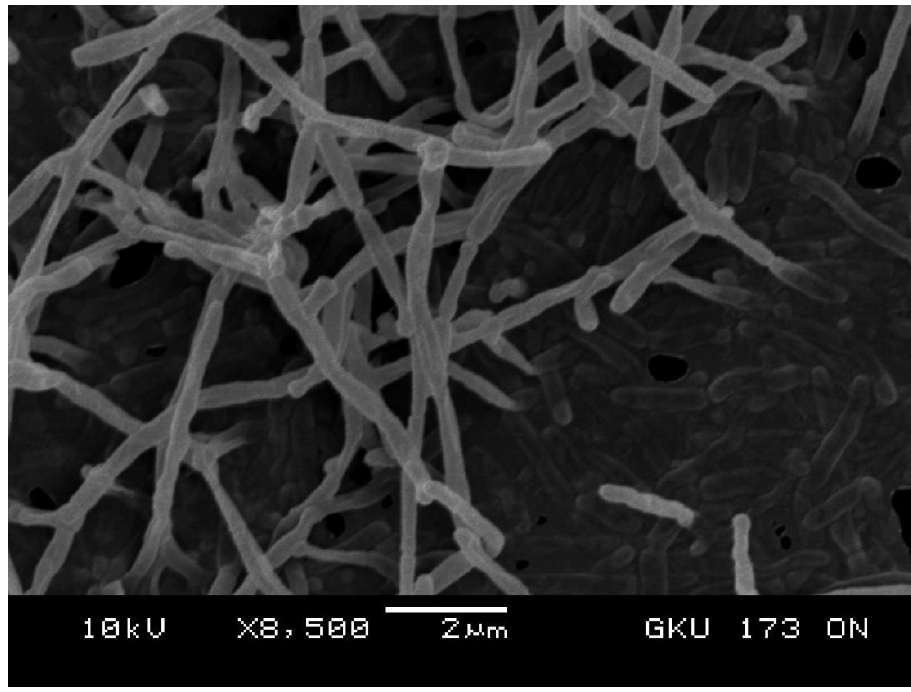
Figure 1. Scanning electron micrograph of fragmentation of aerial hyphae of strain GKU 173 T on ON agar at 28 °C after 21 days. Bar, 2 μm.